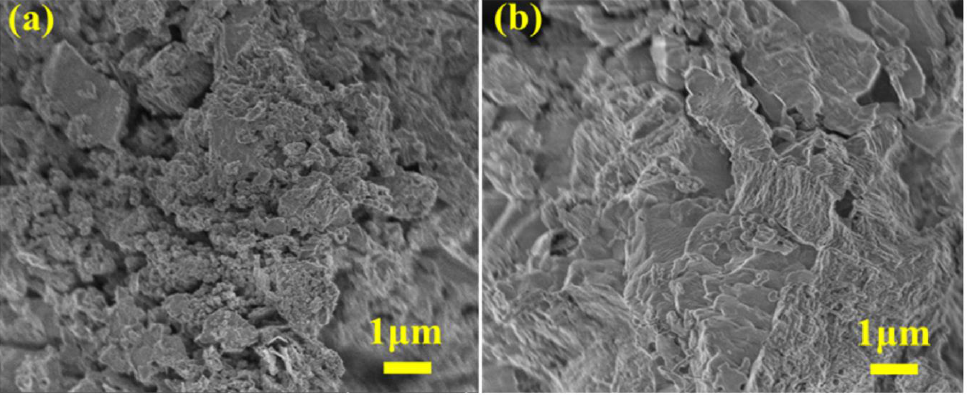
Figure 1. FESEM images of GCN-T ( a ) and GCN-D ( b ). Reproduced with permission from Ref. [54]. Copyright 2016 Elsevier.